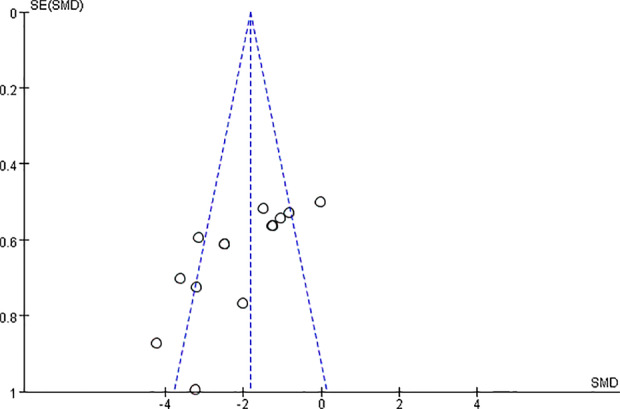
The funnel plot: effect of astragaloside IV on blood urea nitrogen.